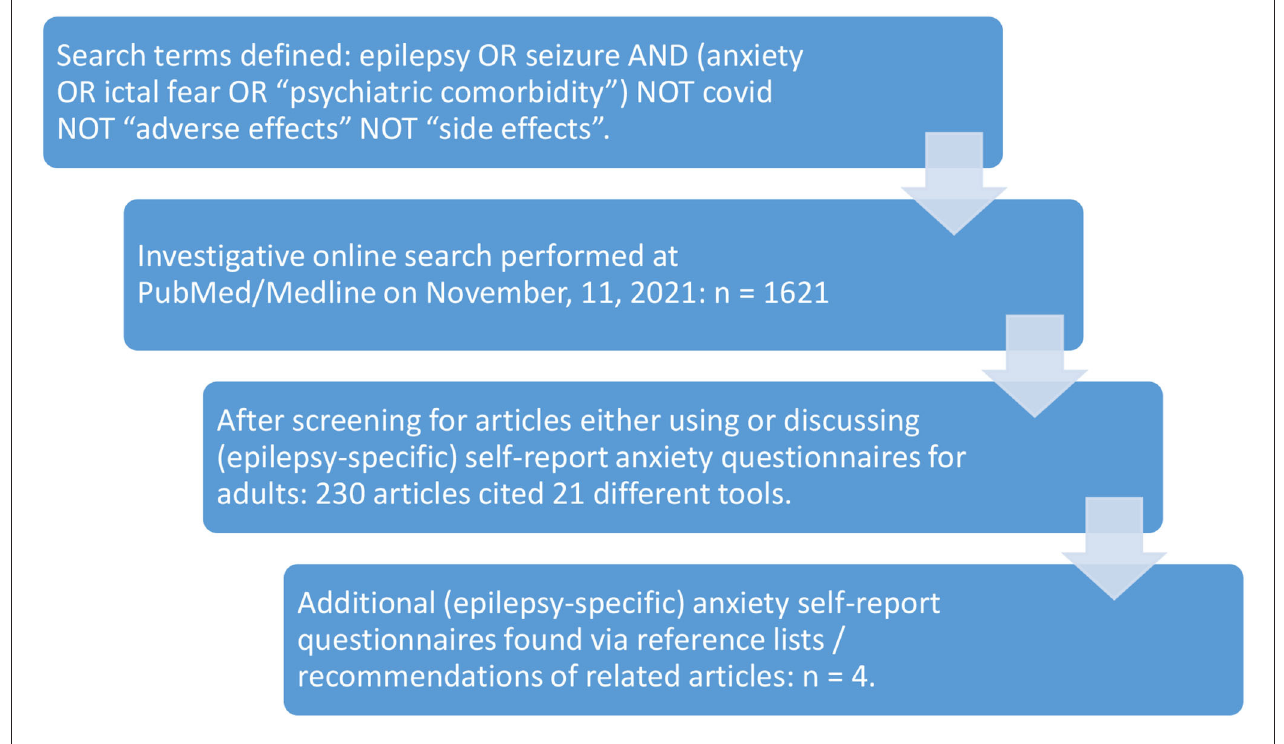
FIGURE 1 | Illustration of the search strategy and selection